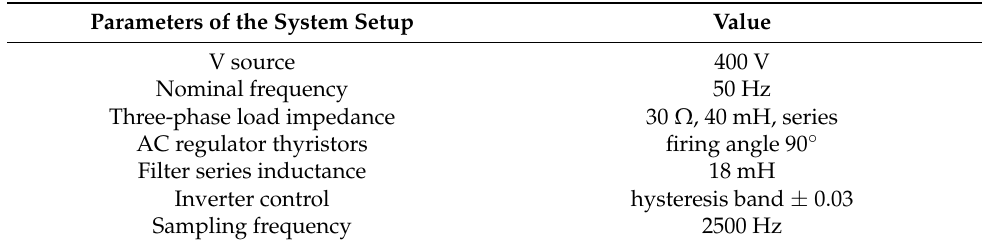
Table 2. Main electric system parameters of the test